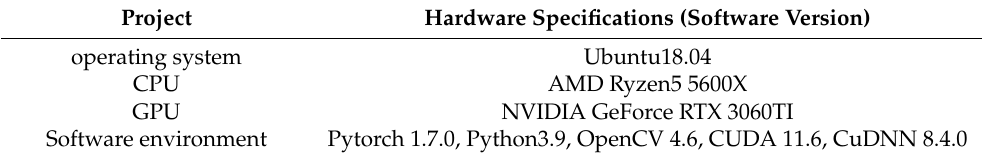
Table 1. The experimental environment.